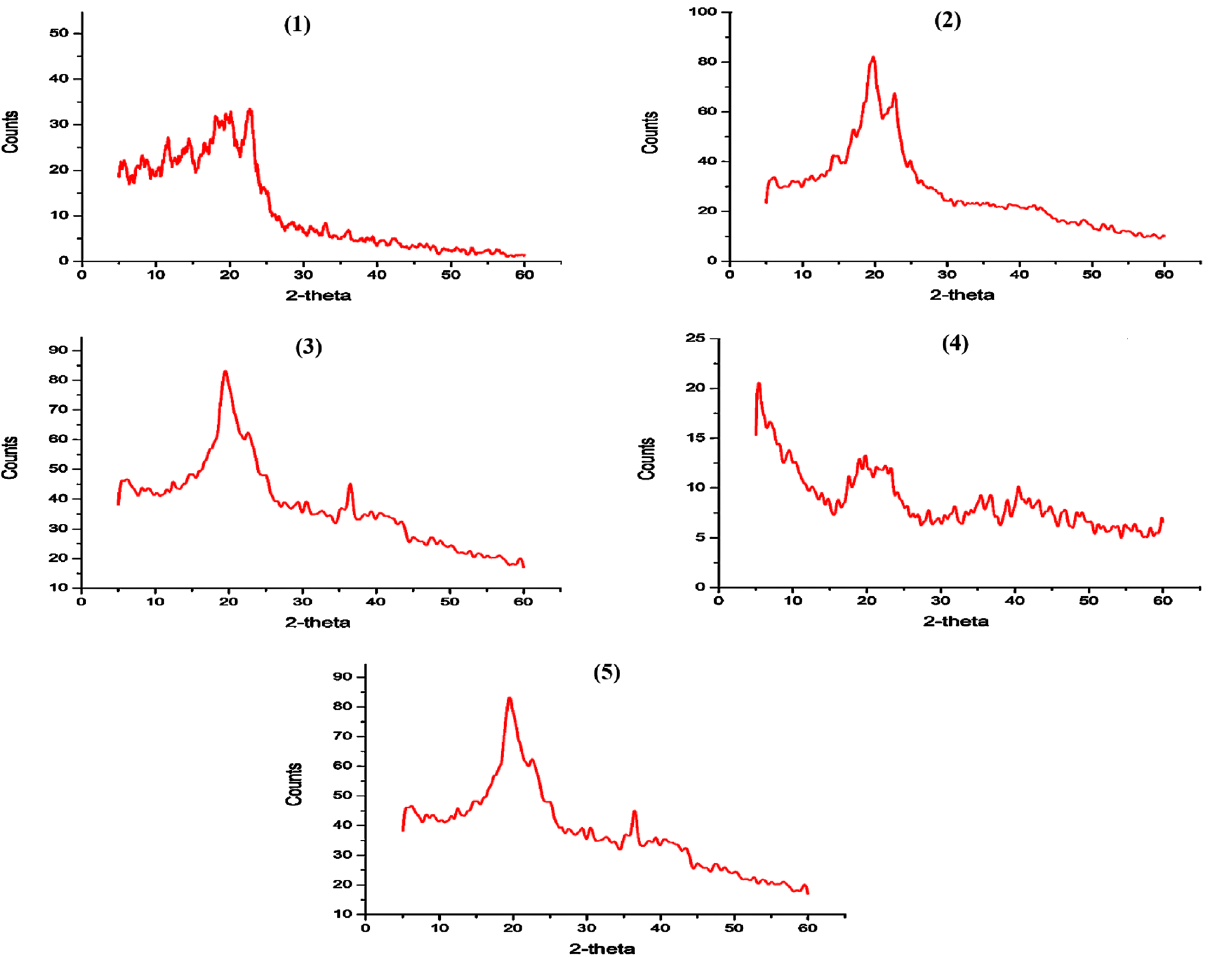
Figure 10. XRD patterns of BC/PVA/Ch (1), BC/PVA/Ch/CuO-NPs1 (2), BC/PVA/Ch/CuO-NPs2 (3), BC/ PVA/Ch/CuO-NPs3 (4), and BC/PVA/Ch/CuO-NPs4 (5) composite membranes. Composite